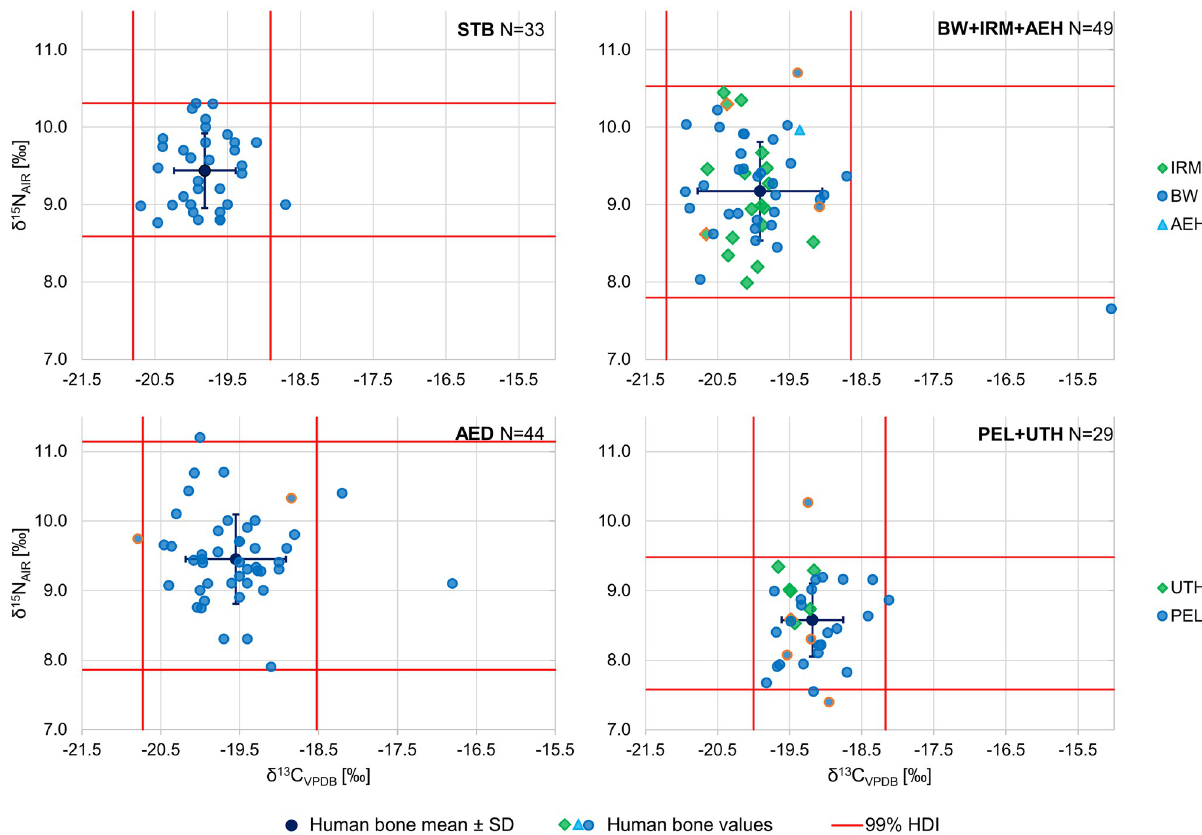
Fig 6. Variability of carbon and nitrogen isotopic ratios. Scatter plots of δ 13 C and δ 15 N values of human bone collagen: Straubing-Bajuwarenstraße (STB, N = 33), Burgweinting, Irlmauth and Alteglofsheim (BW+IRM+AEH, N = 49) in the border zone, and Altenerding (AED, N = 44), Munich- Perlach and Unterhaching (PEL+UTH, N = 29) in the hinterland. Mean values and standard deviations (SD) are based on postweaning individuals (excluding infans I children = values outlined in orange) and were calculated using SPSS. Red lines represent 99% HDIs (calculations: hdr.den function of R package hdrcde [99]) (illustration: